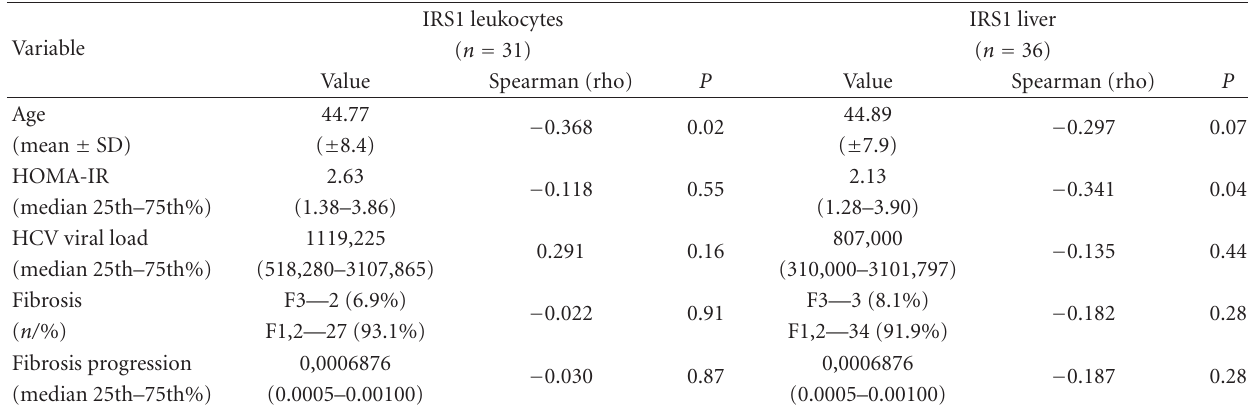
Table 2: IRS1 in leukocytes and liver of patients with hepatitis C virus and their